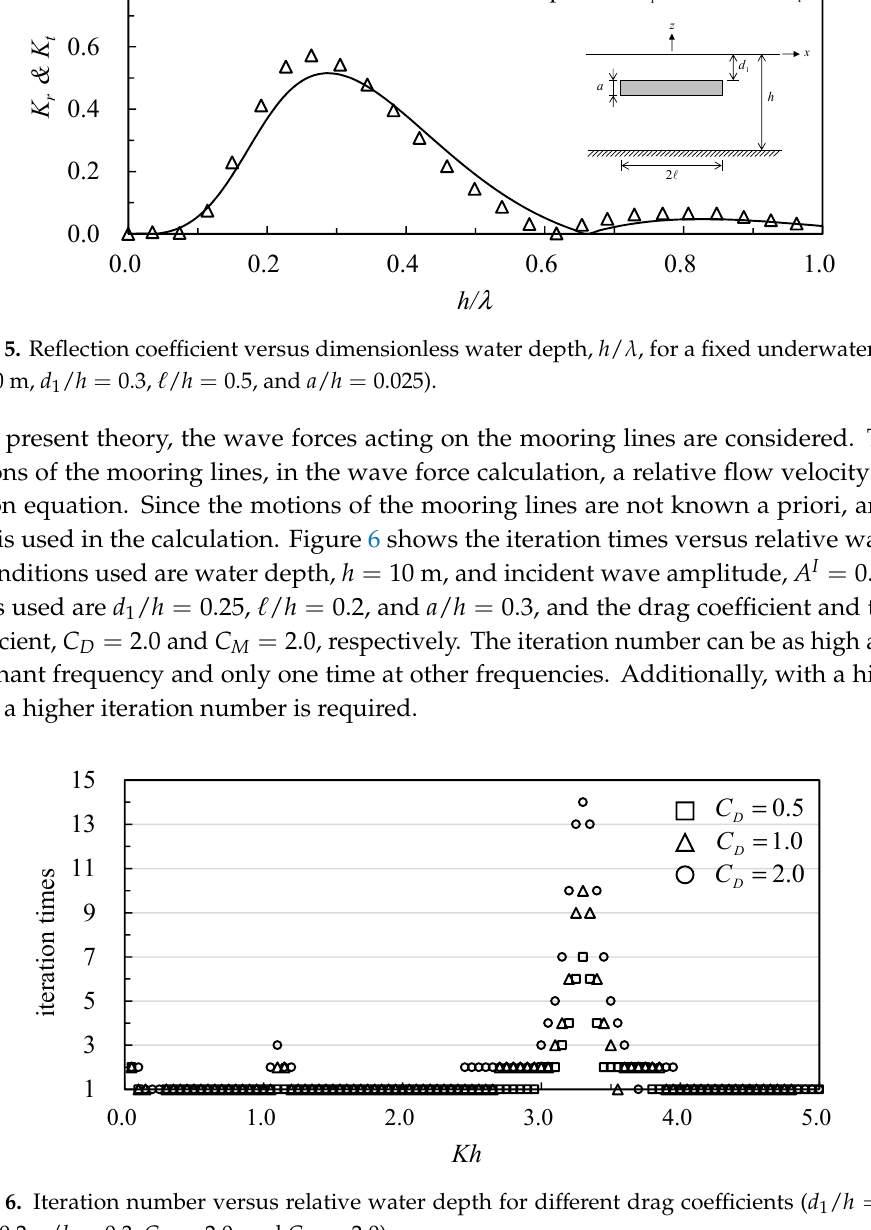
Figure 5. Reflection coe ffi cient versus dimensionless water depth, h / λ , for a fixed underwater plate ( h = 10 m, d 1 / h = 0.3, (cid:96) / h = 0.5, and a / h = 0.025).